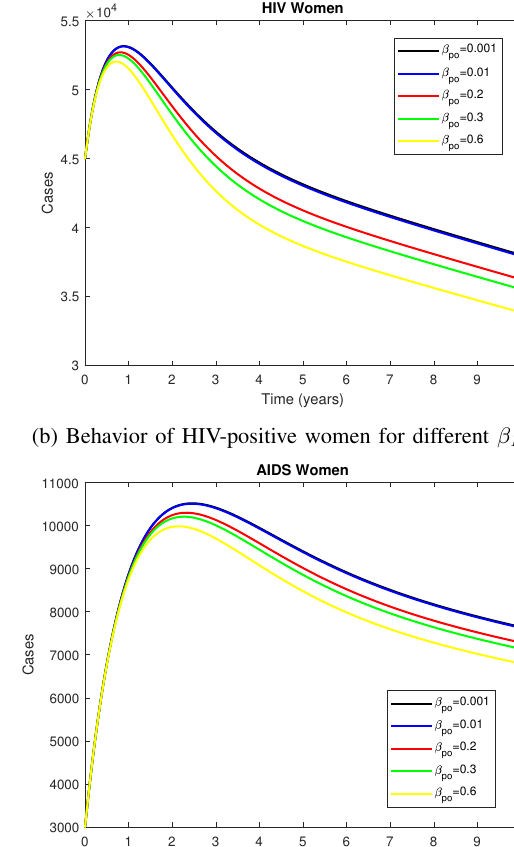
(a) Behavior of HIV-positive men for different β PO . (b) Behavior of HIV-positive women for different β PO .